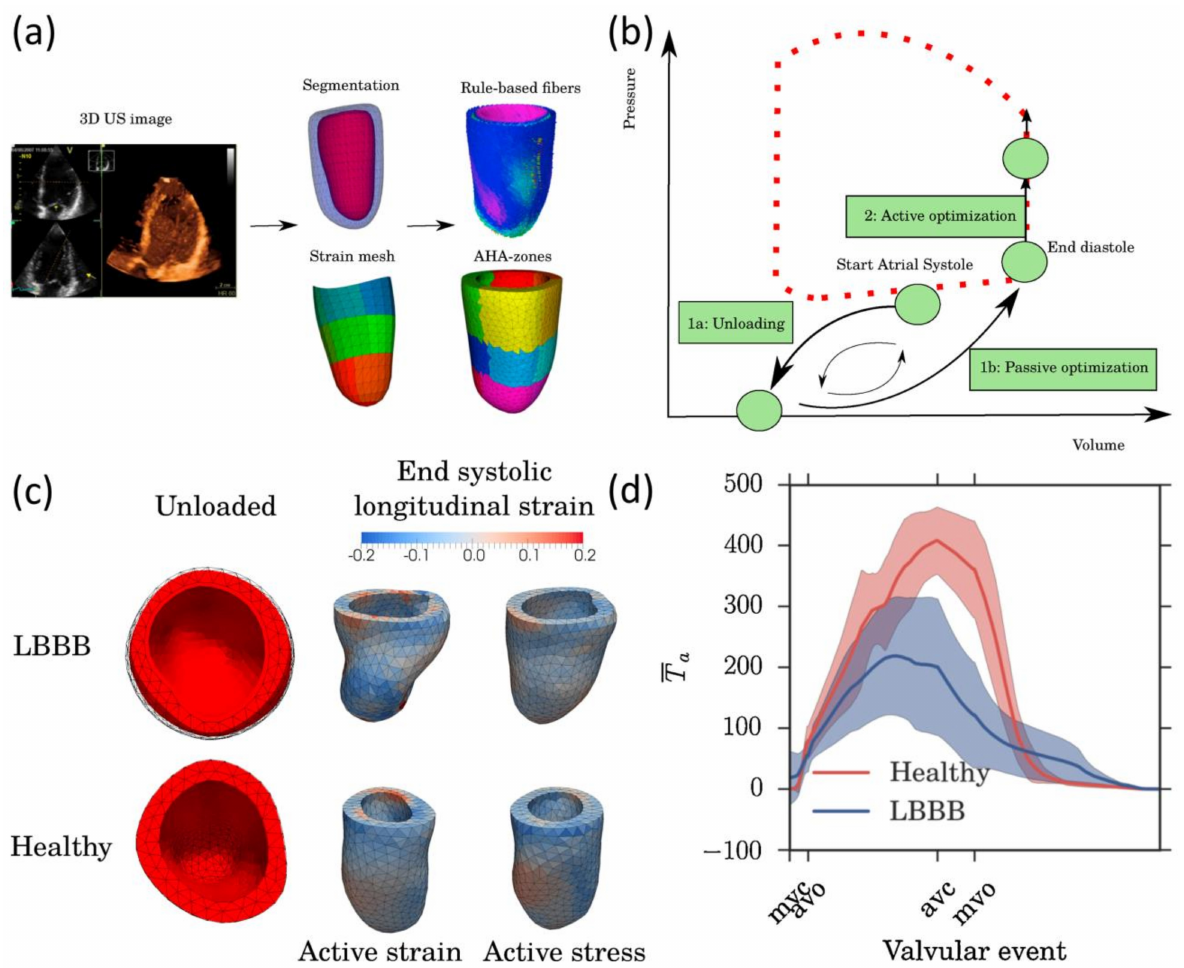
Figure 12. Inverse analysis of left ventricular mechanics. (Reprinted/adapted with permission from Ref. [235]. 2018, Elsevier). ( a ) Preprocessing pipeline, from left to right: medical image-based segmentation and kinematics, anatomic model generation, discretization, partition into 17 AHA standard regions. ( b ) Optimization loops, between unloaded and diastolic configuration for passive properties and between diastole and systole for active contraction parameters. ( c ) Resulting unloaded configuration and strain distributions for a healthy volunteer and an LBBB patient, using active stress and active strain approaches. ( d ) Comparison of activation parameters over time for a healthy individual and an LBBB patient showing the effect of impaired bioelectrical function. Acronyms: mvo, mitral valve opening; mvc, mitral valve closure; avo, aortic valve opening; avc, aortic valve